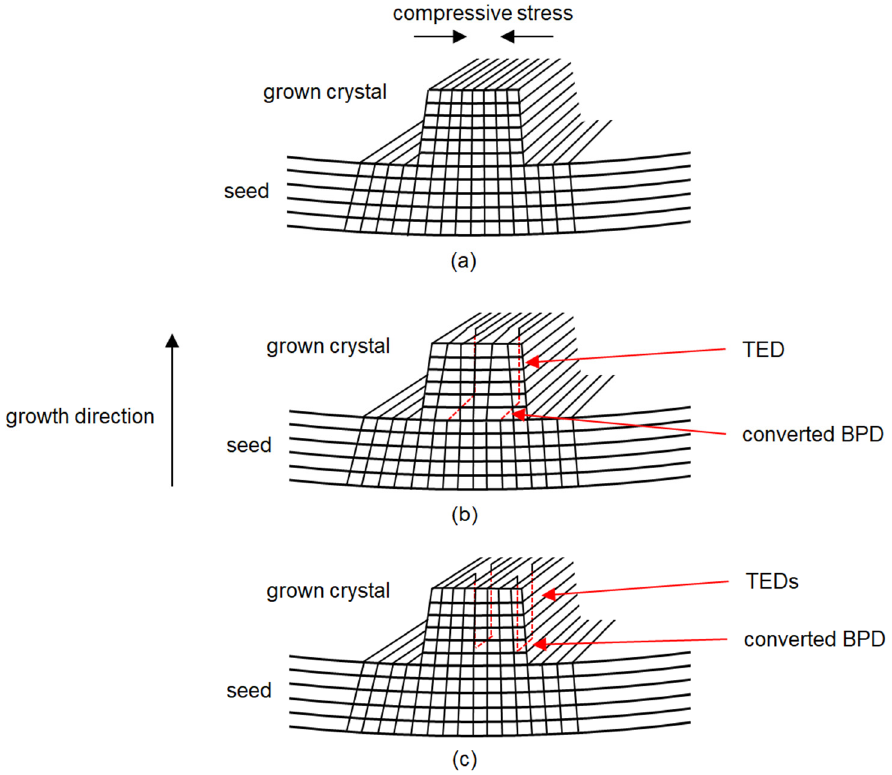
Figure 9. ( a ) Schematic illustration of compressive stress present after heat-up to growth temperatures due to the seed mounted on a graphite plate; ( b ) BPD converted into a TED; ( c ) BPD converted into two BPDs.